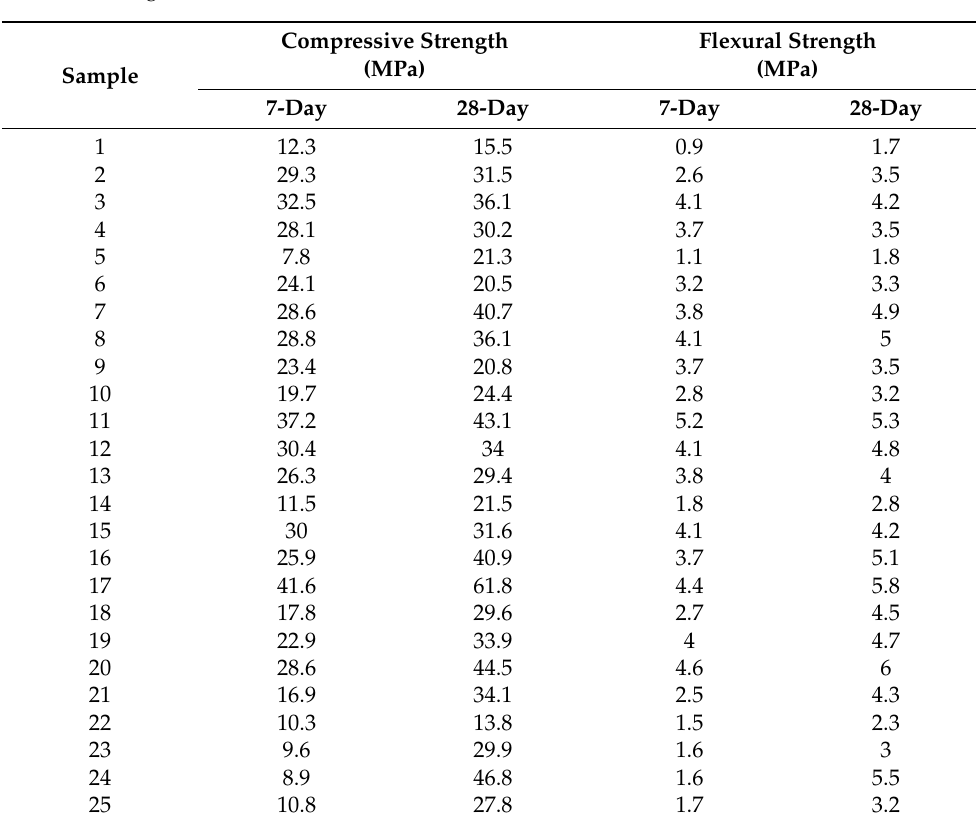
Table 5. Orthogonal test L25 (5 3 ) and test